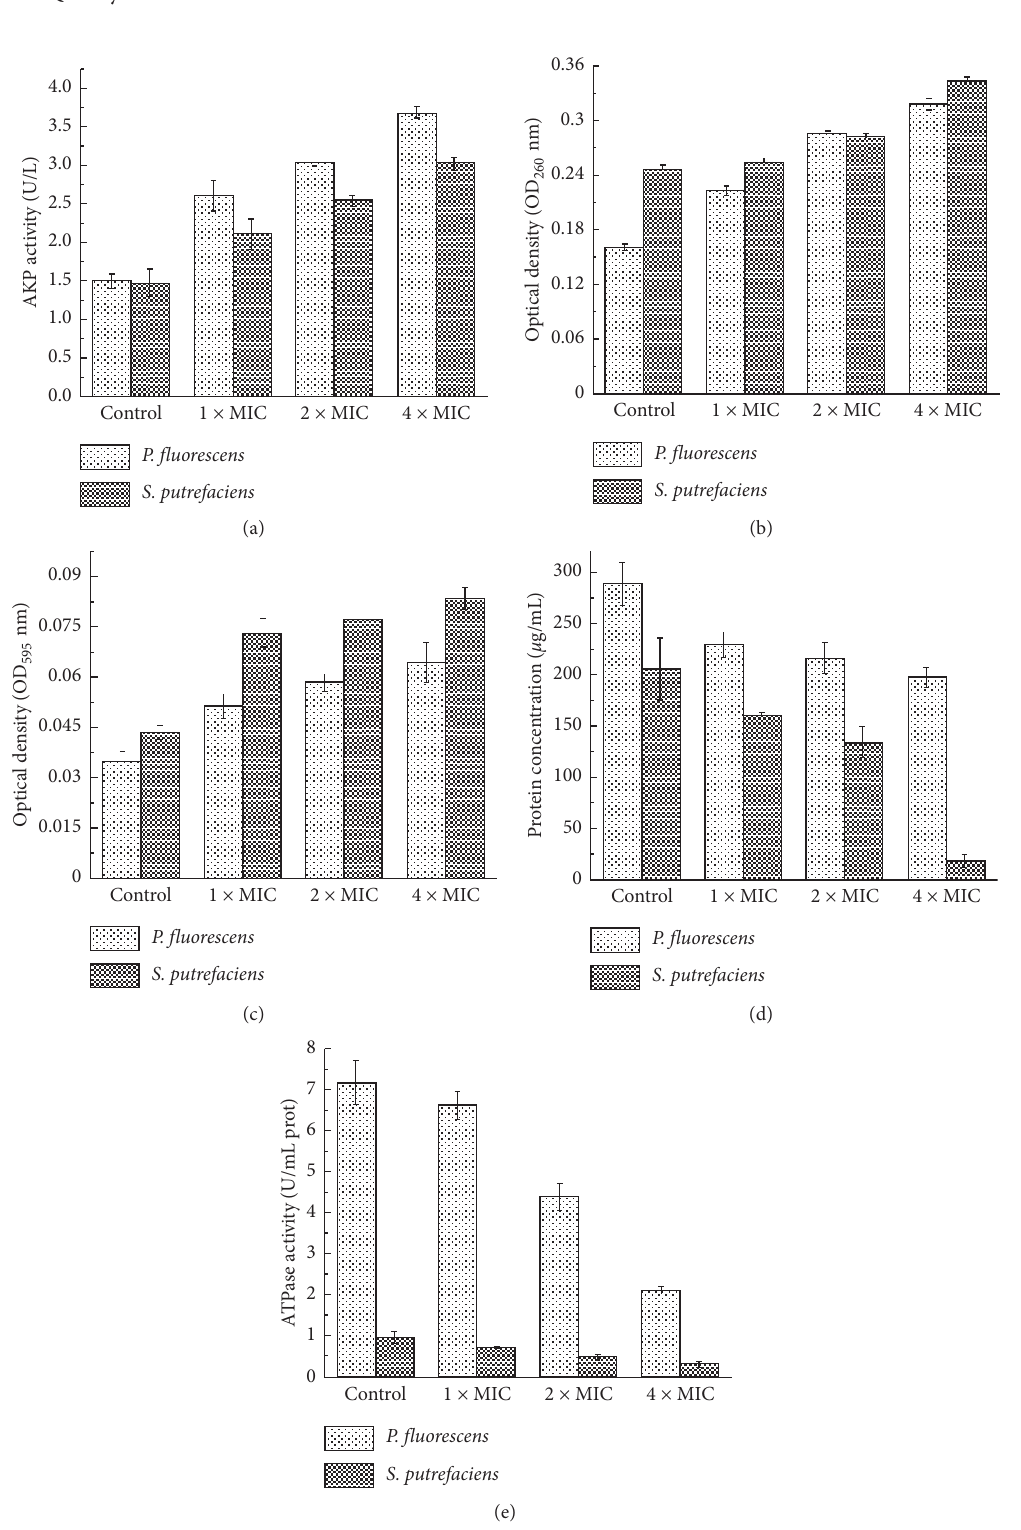
Figure 3: Alkaline phosphatase (AKP) activity (a), leakage of intracellular nucleic acids (b) and intracellular proteins (c), protein leakage (d), and ATPase activity (e) of daphnetin against P. fluorescens and S. putrefaciens